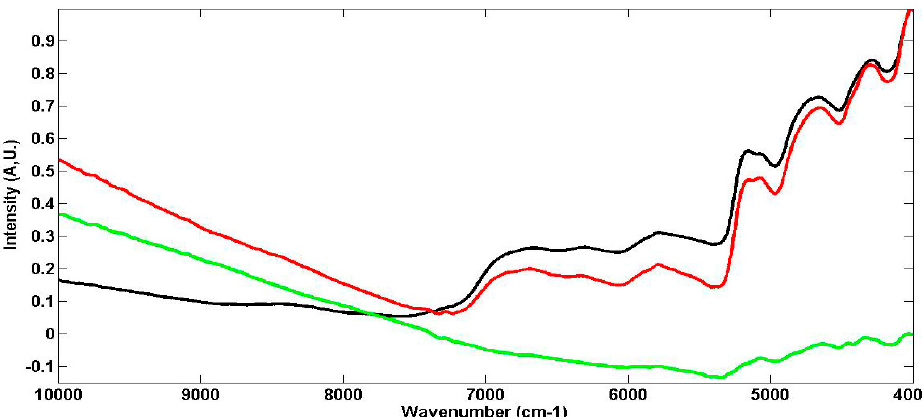
Figure 2. Example of control (black), exposed (red), and difference (green) near infrared FTNIR spectra for a Vicia faba sample treated with 20 g·L − 1 As. The negative values observed in the range between 7500 and 4000 cm − 1 of the difference spectrum show a reduction of the molecular absorptions in the exposed samples with respect to the control sample.